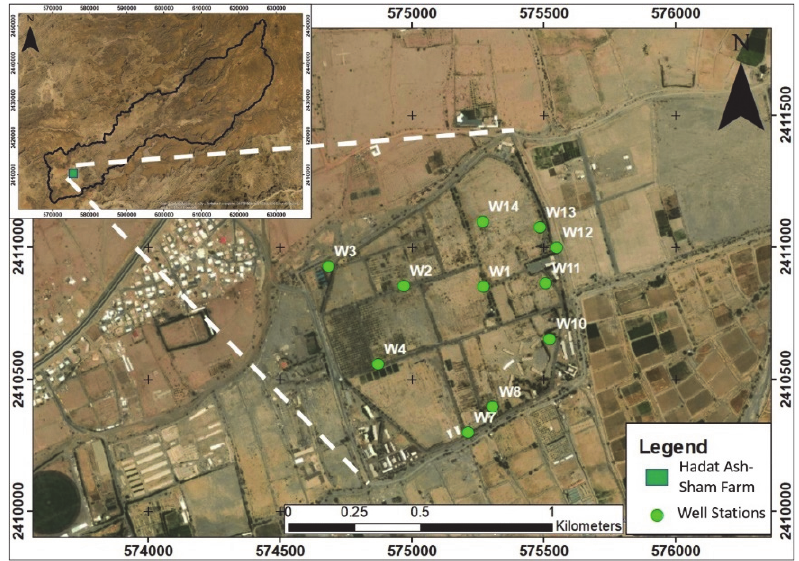
Figure 6. Location of Hadat Ash ‐ Sham Farm Station.